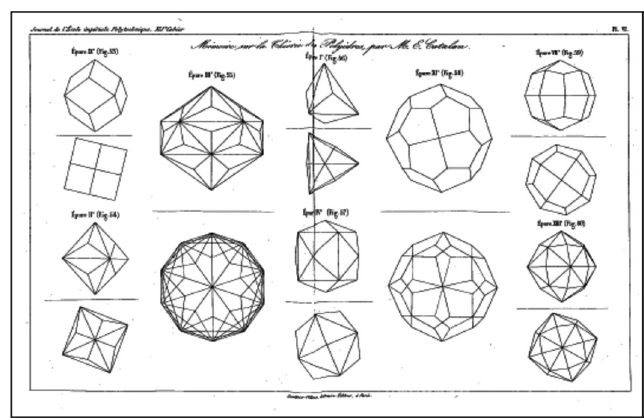
Fig. 5. Sketches of E. Catalana presenting semi­regular polyhedrons (source: M.E. Catalan 1865)